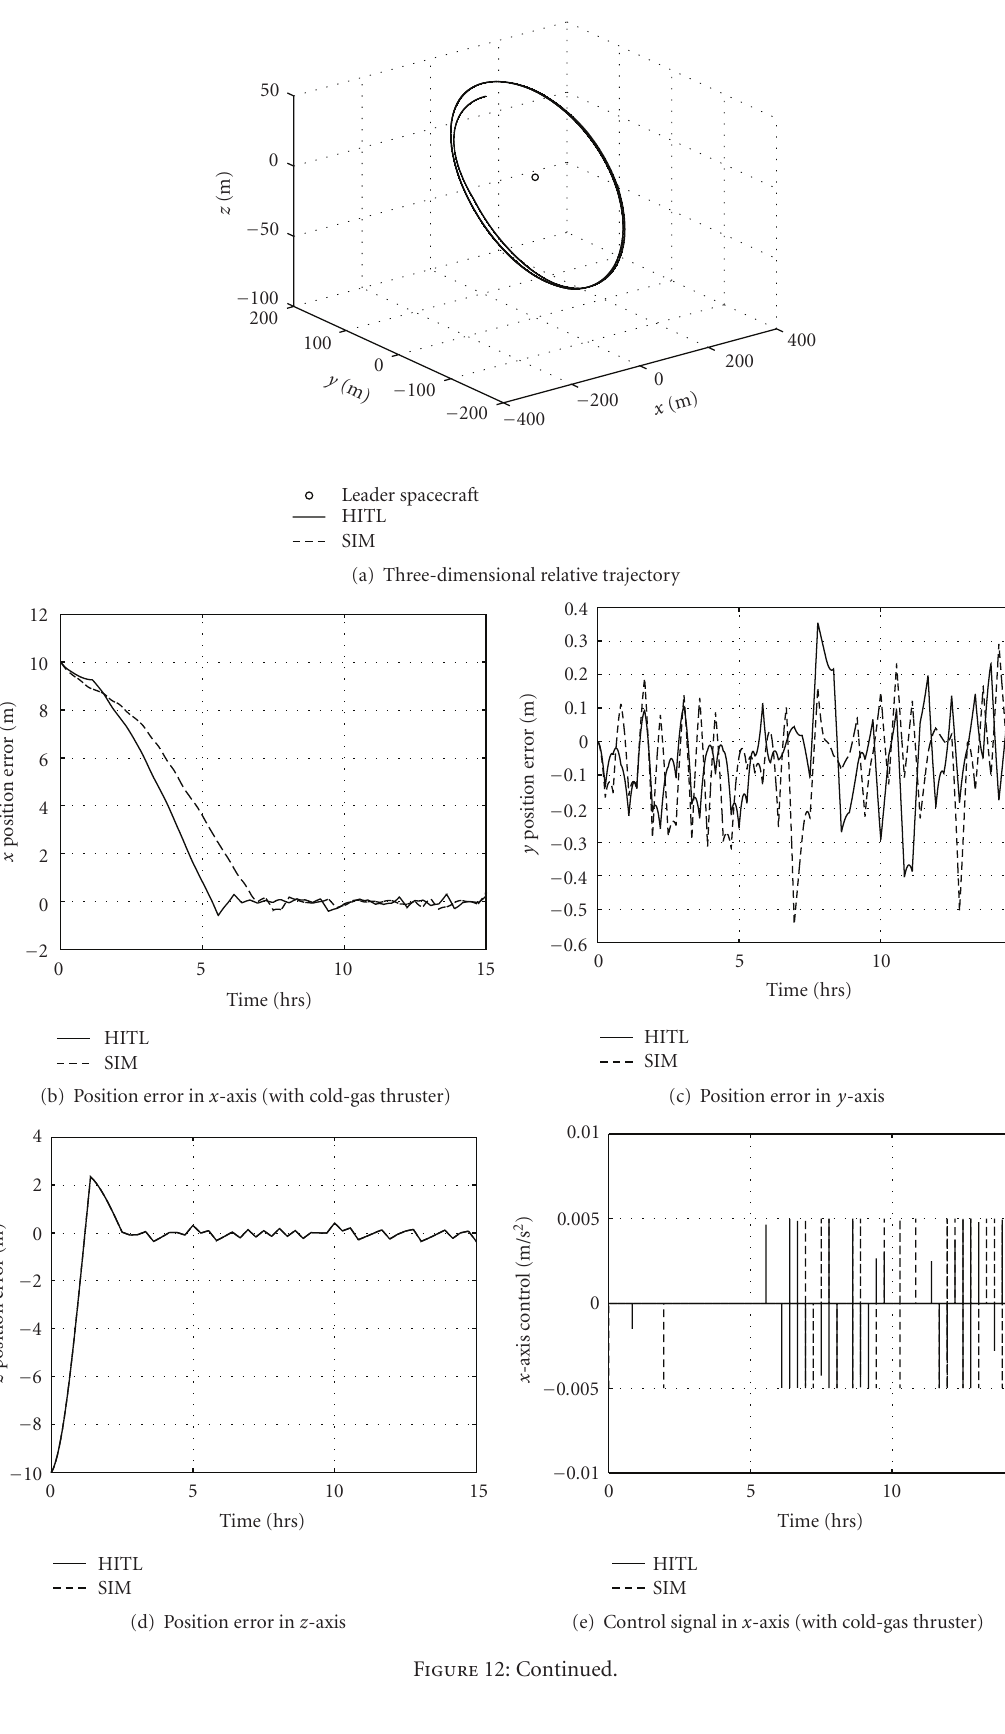
(e) Control signal in x -axis (with cold-gas thruster) Figure 12: